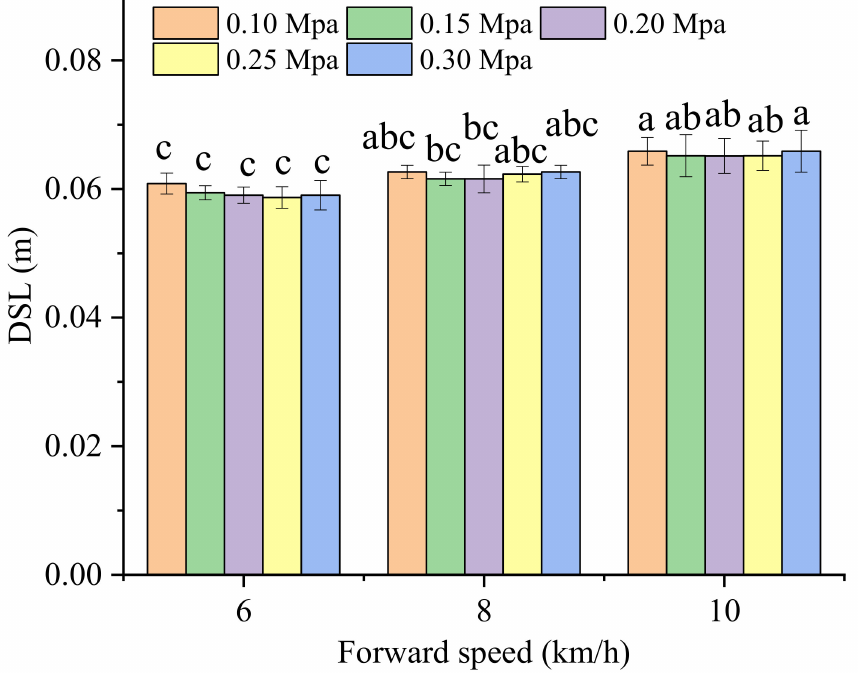
Figure 15. The distance between the seeds and the liquid starter fertilizer (DSL) with different treatments. Only the values that are each denoted by different letter(s) ( a – c ) differ significantly at p <